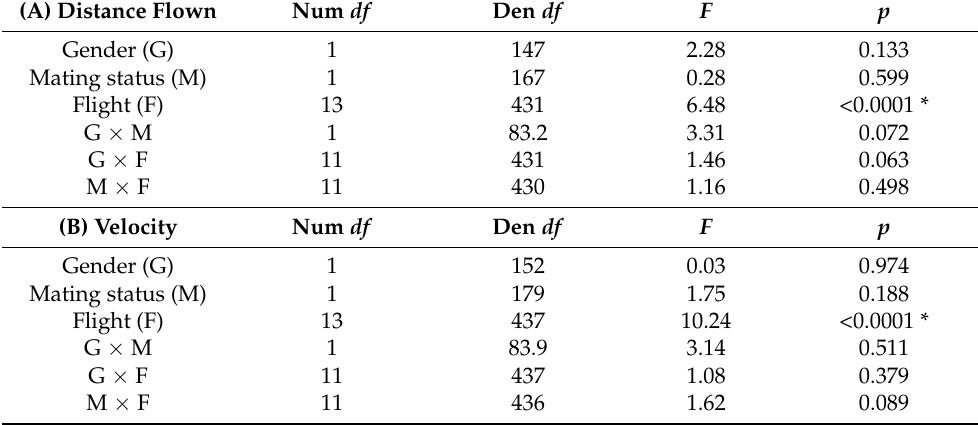
Table 1. Results of repeated measures analyses examining the effects of gender, mating status (i.e., unmated vs. unknown), the 24 h flight trial (i.e., one through fourteen), and their interactions on ( A ) total distance flown, ( B ) velocity, ( C ) mean maximum bout distance flown, and ( D ) mean maximum bout time length recorded across experimental weevils tethered to flight mills over their life time (i.e., flights one through